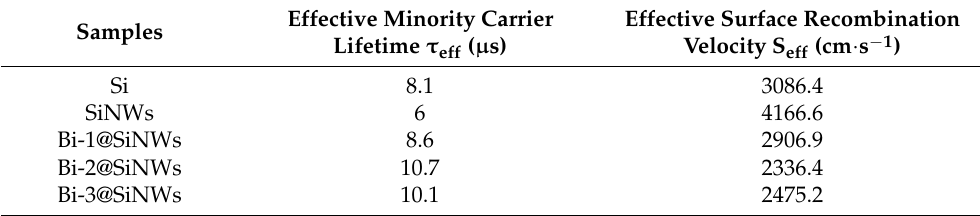
Table 2. Effect of Bi-passivation on τ eff and S eff of